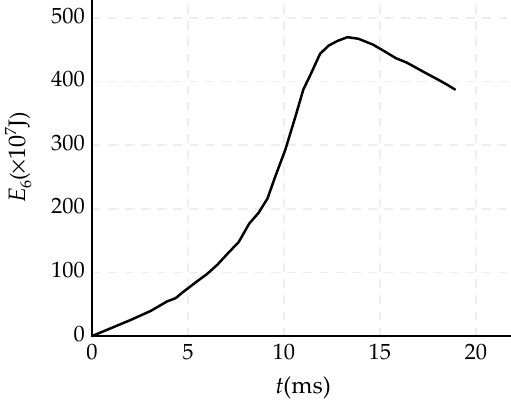
Figure 15. Propellant gas energy.